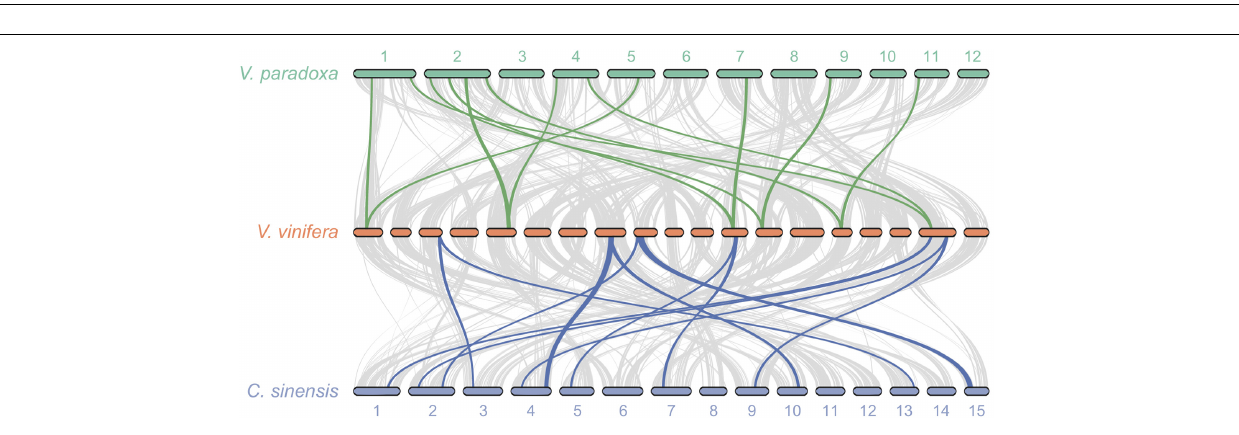
FIGURE 4 | Syntenic relationships between Vitis vinifera (grape) and both shea (top) and the tea plant Camellia sinensis (bottom) reveal widespread patterns of gene duplication, providing further evidence of WGD events in the two latter species subsequent to their divergence from the Rosids. The gray lines connect all regions of synteny between species (i.e., the background collinearity). Between shea and grape, a total of 15 2:1 syntenic blocks are detected, containing 1,035 genes. Of those, an illustrative subset of six blocks are highlighted (green lines). Similarly, of the 21 2:1 syntenic blocks (1,309 genes) between tea plant and grape, six are highlighted (blue